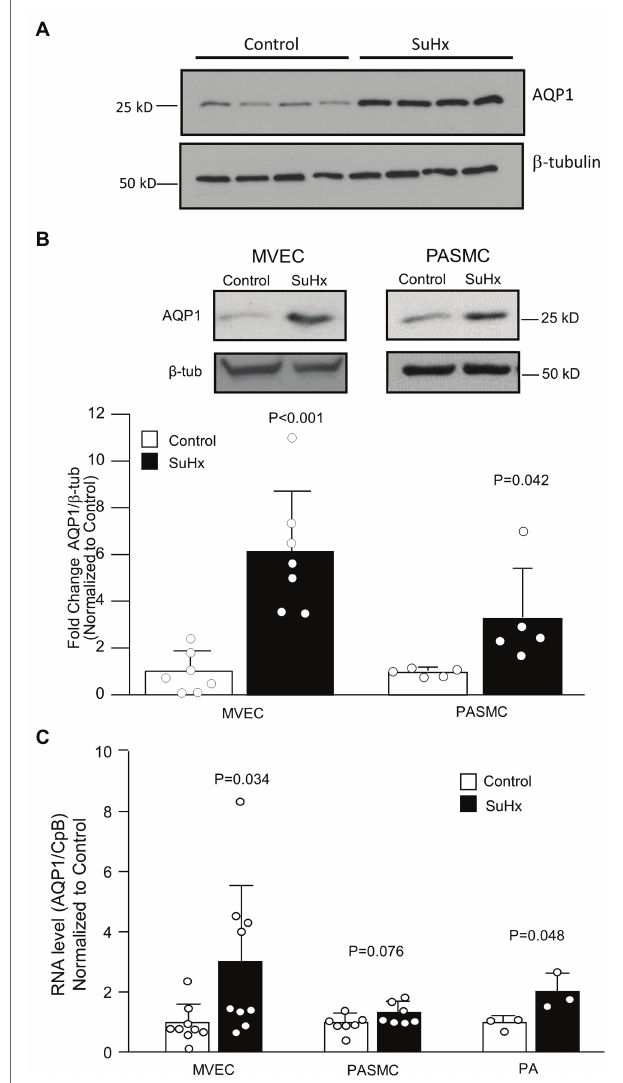
FIGURE 3 | Pulmonary vascular AQP1 expression. (A) Immunoblot image showing AQP1 protein levels in pulmonary arteries (PA) from control and SuHx rats. (B) Representative images and bar graphs (mean ± SD values) for AQP1 protein levels in microvascular endothelial cell (MVEC) and PASMCs isolated from control and SuHx rats. (C) Bar graphs (mean ± SD values) for mRNA levels of AQP1 relative to cyclophilin B (CpB; housekeeping) and normalized to values in Control rat samples. For all graphs, each dot represents samples from different animals and values of p determined by t